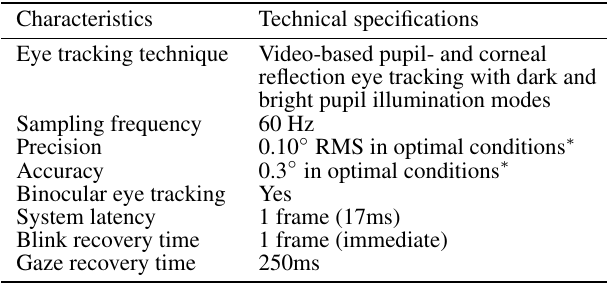
Figure 2. Experimental setup of Screen-based eye tracker Table 1. Tobii pro nano technical specifications. (Tobii Pro,